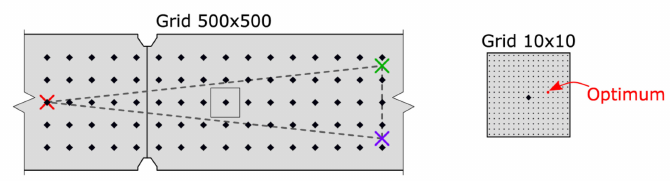
Figure 10. Graphical representation of search grids.